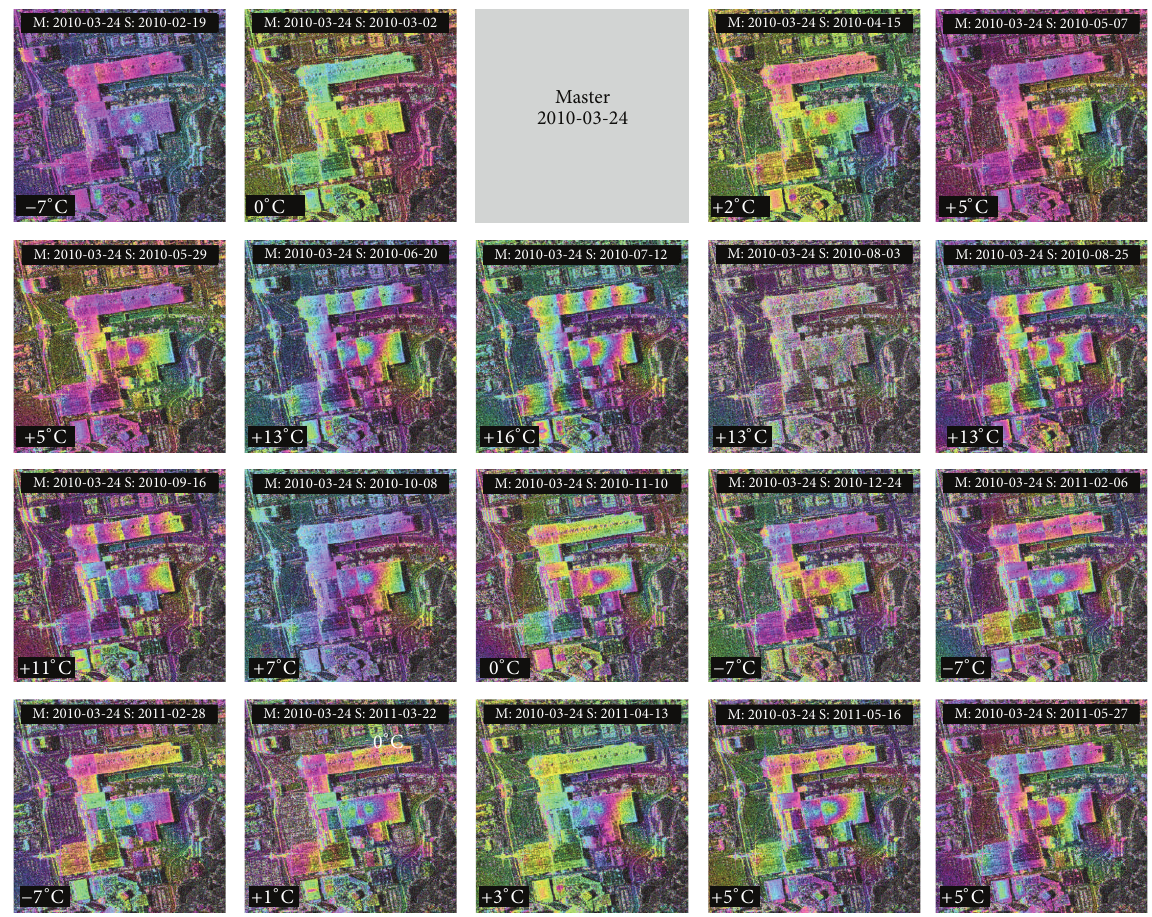
Figure 11: Time series of TerraSAR-X ascending stack, showing flattened interferograms. Area: Convention Center in Las Vegas, USA. Temperature annotations indicate the relative temperature difference to the master image (2010-03-24), source